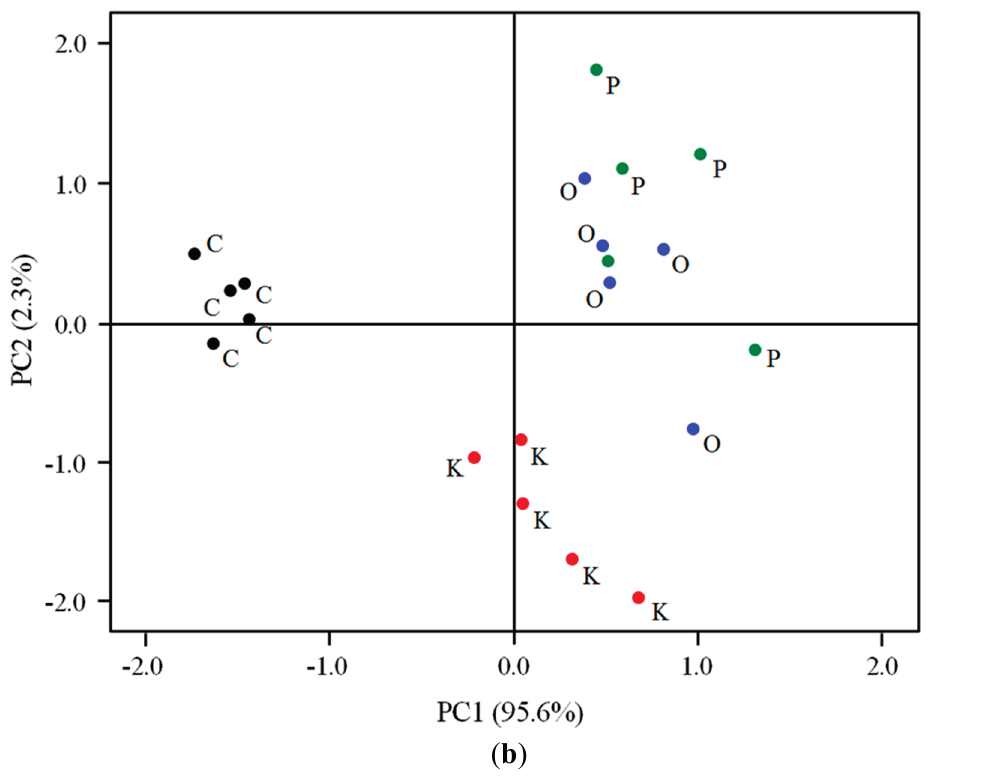
Figure 2. Differentiation of wines made from grapes exposed to smoke of different fuel types based on principal component analysis of sensory attributes: plots of ( a ) the sensory attributes vector loadings; and ( b ) the resultant scores of the replicates of fuel treatments shown on the first two principal axes of